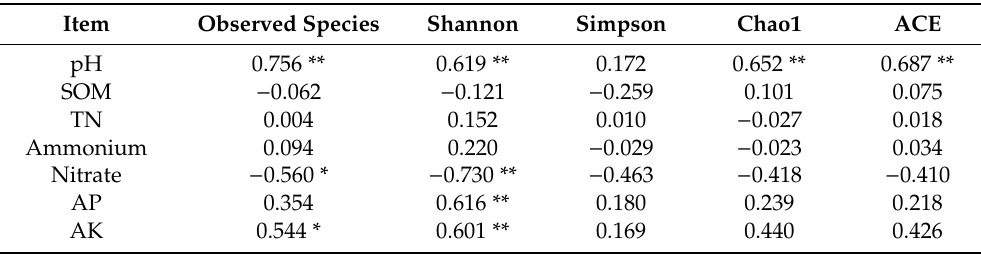
Table 3. Pearson correlation coe ffi cients between the alpha diversity index of the soil bacterial community and soil properties.